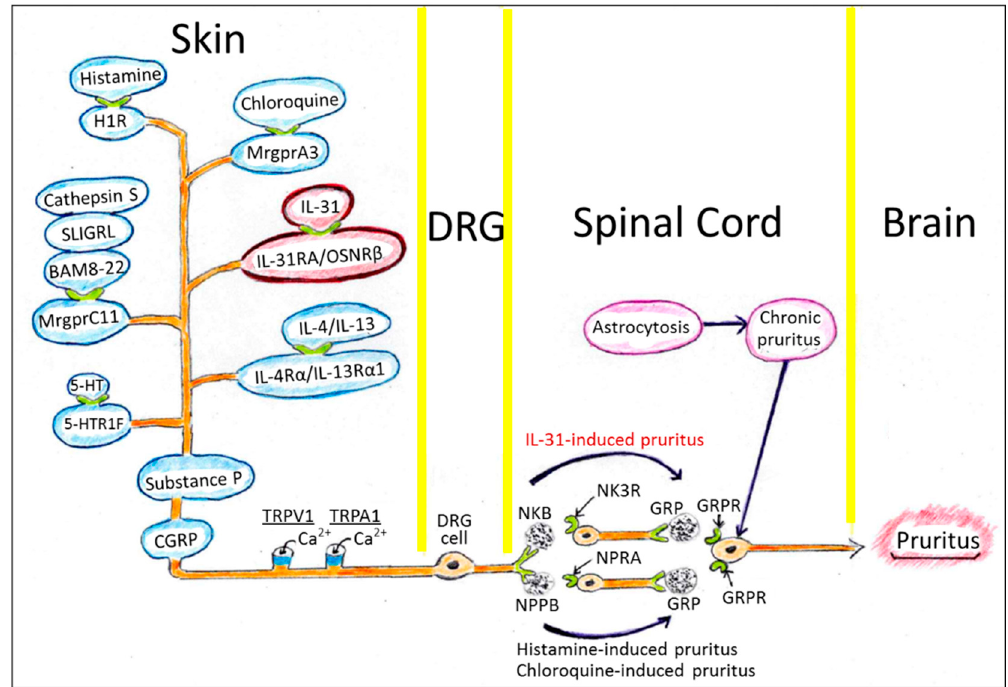
Figure 2. Murine sensory nervous system transmitting the sensation of pruritus.